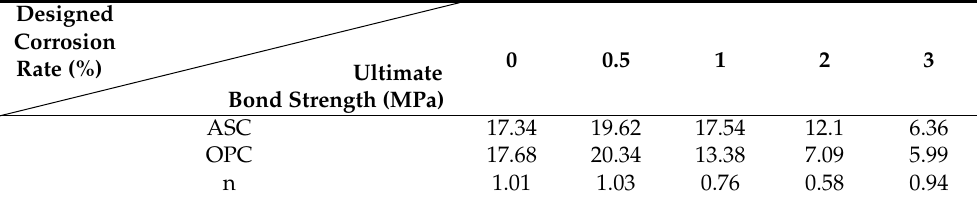
Table 7. Designed corrosion degree and average ultimate bond